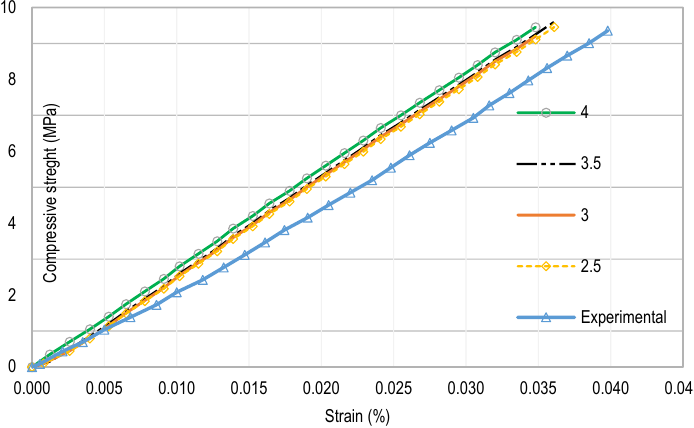
Figure 9. Compression curves in the elastic zone for each mesh size.